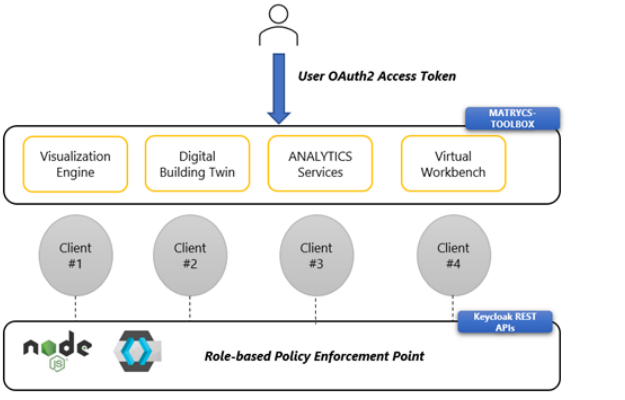
Figure 7. MATRYCS Toolbox integration with security